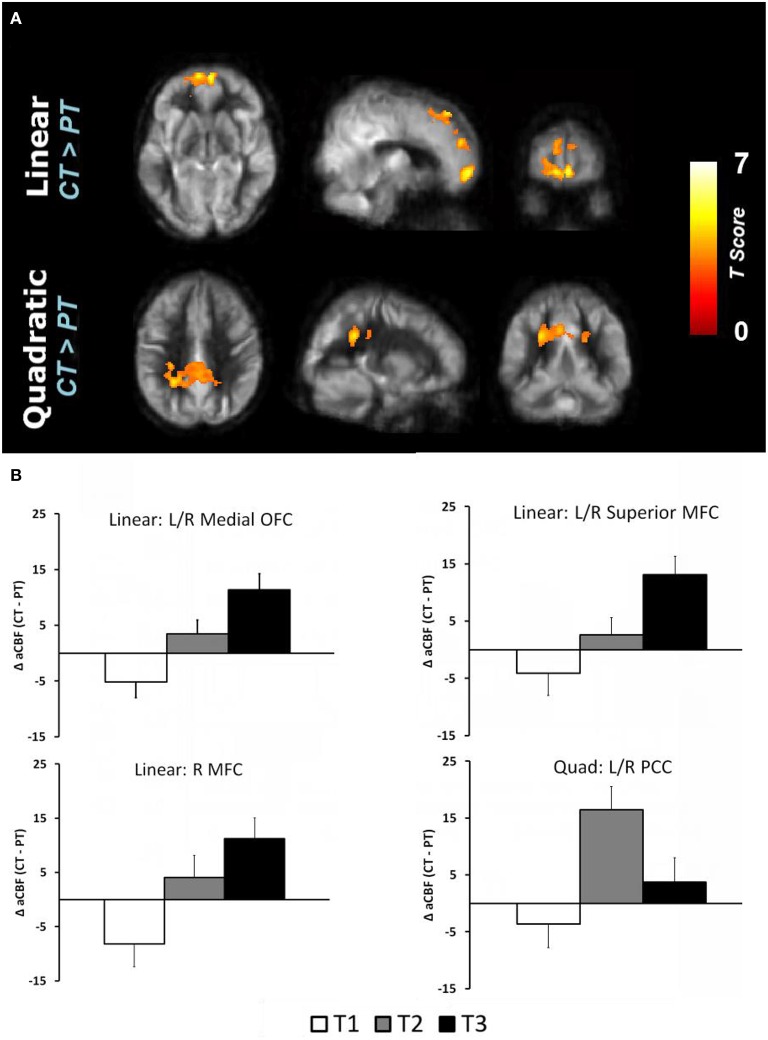
(A) Reultss of voxel based analysis are superimposed on an average CBF map of all participants for linear (T1 to T3 change) and quadratic (maximal T2 change) interaction contrasts at p < 0.01 (FWE corrected) and k ≥ 1232 mm3. The regions experiencing a linear increase are located in the frontal regions while the regions experiencing a quadratic pattern of CBF increase are located in the posterior regions. (B) The regional CBF difference between CT and PT (i.e., CT–PT) groups are shown to depict linear and quadratic trends. For instance, the CBF of bilateral medial OFC increases from T1 to T2 and T3, i.e., linear trend, whereas the bilateral posterior cingulate cortex (PCC) increases from T1 to T2 and then decreases at T3, i.e., quadratic trend.